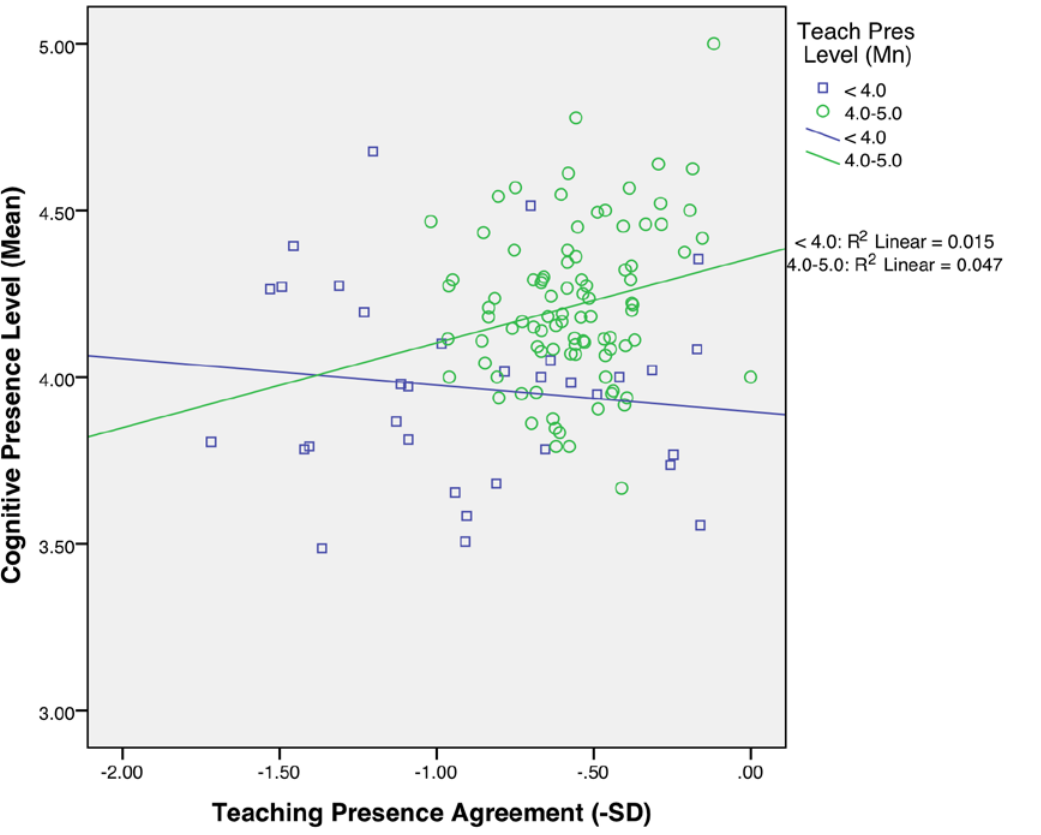
Figure 1 . Effect of teaching presence agreement on cognitive presence level by teaching presence